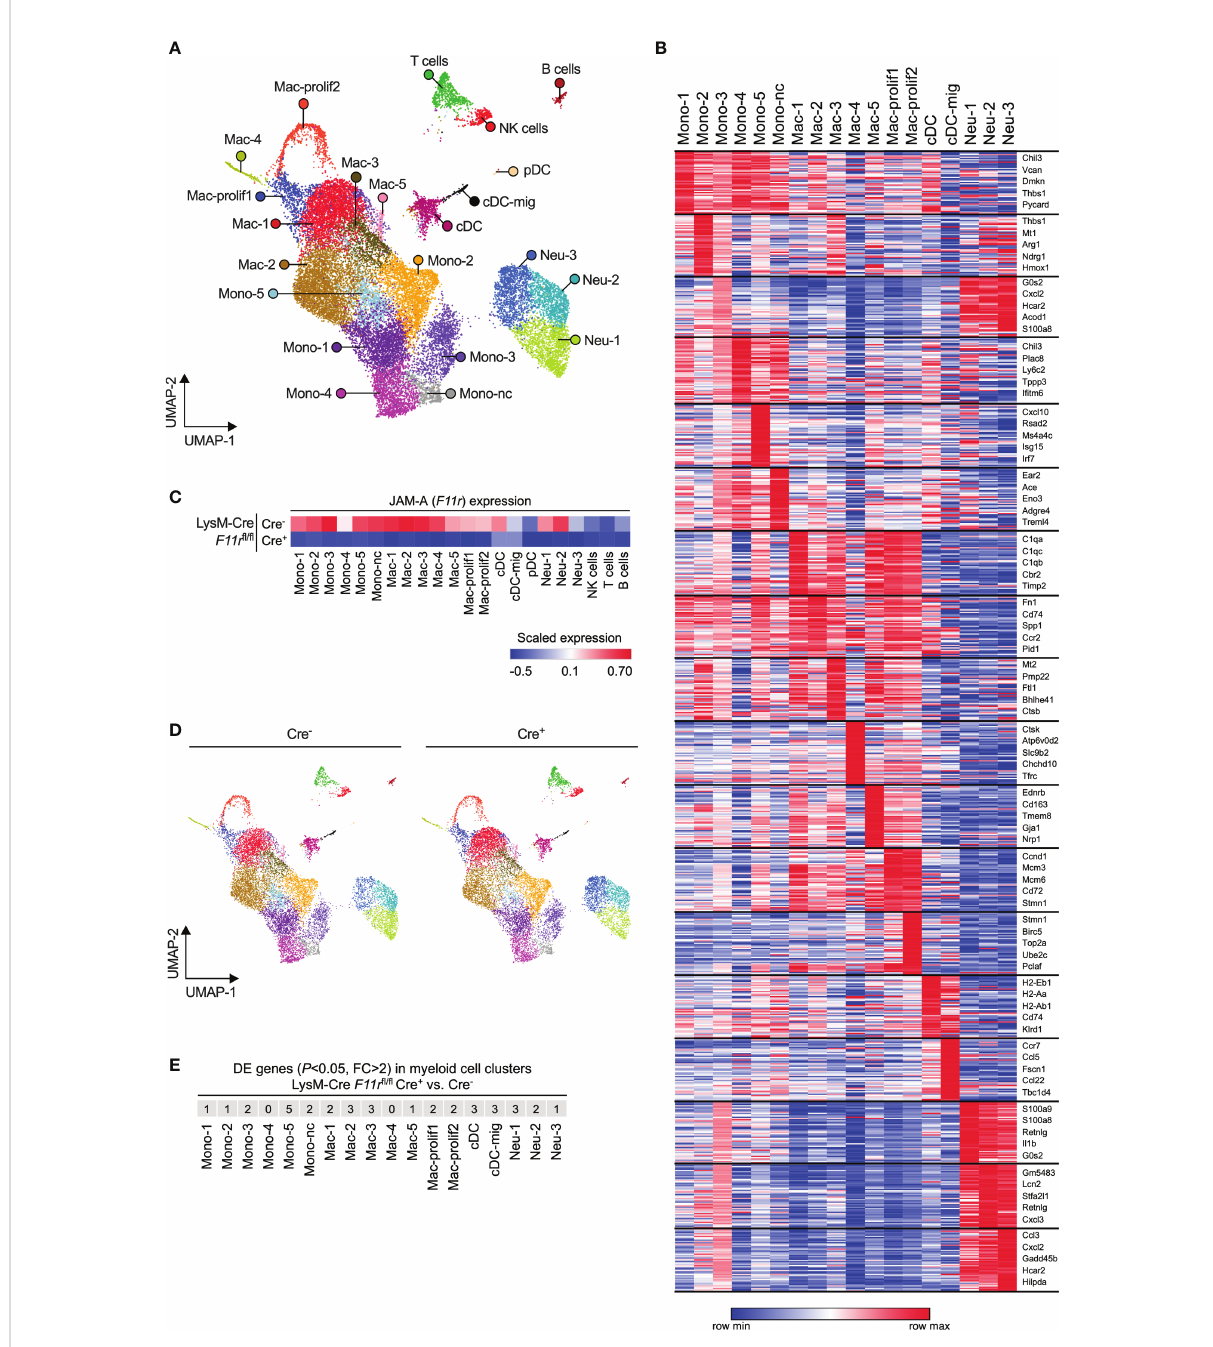
FIGURE 4 JAM-A does not affect myeloid cell diversi fi cation in the tumor microenvironment. (A) UMAP plot showing CD45 + immune cells from LLC tumors of both F11r fl ox/ fl ox LysM-Cre - and F11r fl ox/ fl ox LysM-Cre + mice color-coded by clusters de fi ned based on single-cell RNA-seq data. (B) Heatmap showing the top 50 enriched genes in each myeloid cell cluster. The top 5 enriched genes per cluster are highlighted. See Supplementary Table 1 for list of top 50 enriched genes for all clusters shown in panel (A) . (C) Heatmap showing F11r (encoding JAM-A) expression in tumors of F11r fl ox/ fl ox LysM-Cre - and F11r fl ox/ fl ox LysM-Cre + mice based on single-cell RNA-seq data. (D) UMAP plots showing CD45 + immune cells from LLC tumors of F11r fl ox/ fl ox LysM-Cre - or F11r fl ox/ fl ox LysM-Cre + mice color-coded by clusters shown in panel (A) . (E) Number of differentially expressed (DE) genes (adjusted P value < 0.05, fold change (FC) > 2) between F11r fl ox/ fl ox LysM-Cre + and F11r fl ox/ fl ox LysM-Cre - mice within each myeloid cell cluster. See Supplementary Table 2 for full list of DE